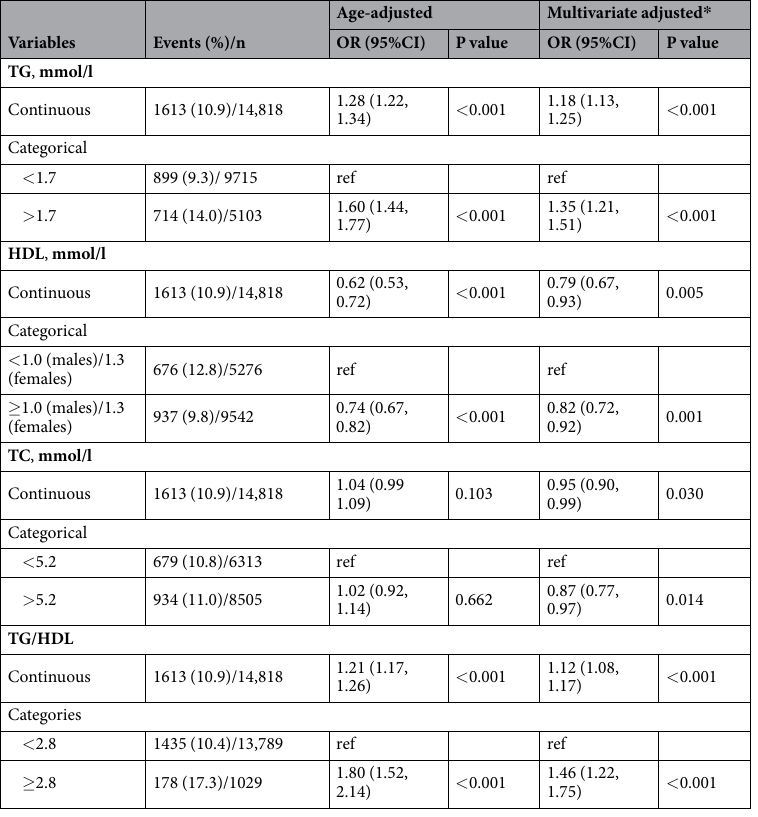
Table 7. Odds ratios of lipid levels for NOD by logistic regression (remove the group of patients with statins). Abbreviations: TG = triglycerides, HDL = high-density lipoprotein, TC = total cholesterol, NOD = new-onset diabetes. * Adjusted for age, gender, clinical center, SBP, DBP, smoking and drinking status, baseline FPG, and